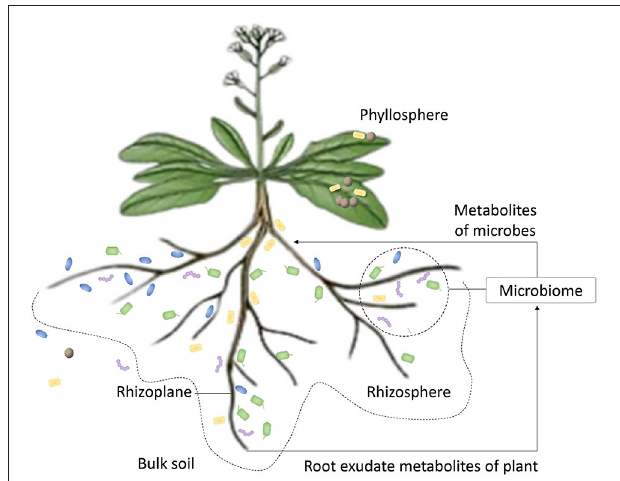
FIGURE 1 | The scheme of plant on symbiosis with microorganisms. The plant provides microbial community carbon, nitrogen nutrient substance, and some root exudate metabolites, such as amino acids, sugars, and organic acids. These substances can drive the enrichment of microbes from bulk soil to the region of rhizosphere. Microbes that are adapted to the exudate metabolites can pass the selection by plant and finish colonization. Microbes also produce metabolites, such as hormones and secondary metabolites, to participate in the regulation of metabolism.